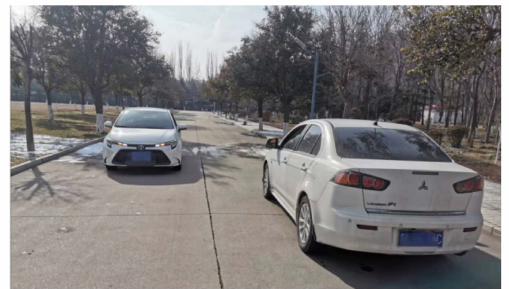
Figure 8. Obstacle state update